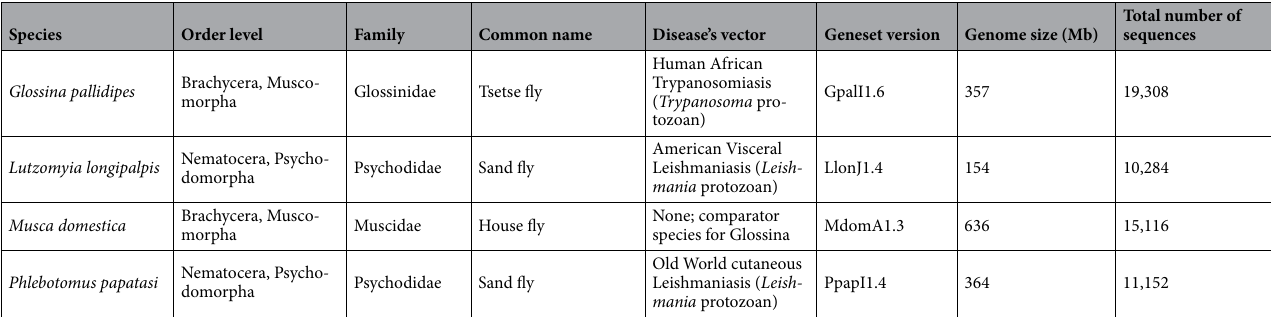
Table 2. Characteristics of genome-deduced proteomes (all* from VectorBase, www.vecto rbase .org ) from hematophagous Diptera insects used in this work. *Except for Drosophila ; 1. Obtained from